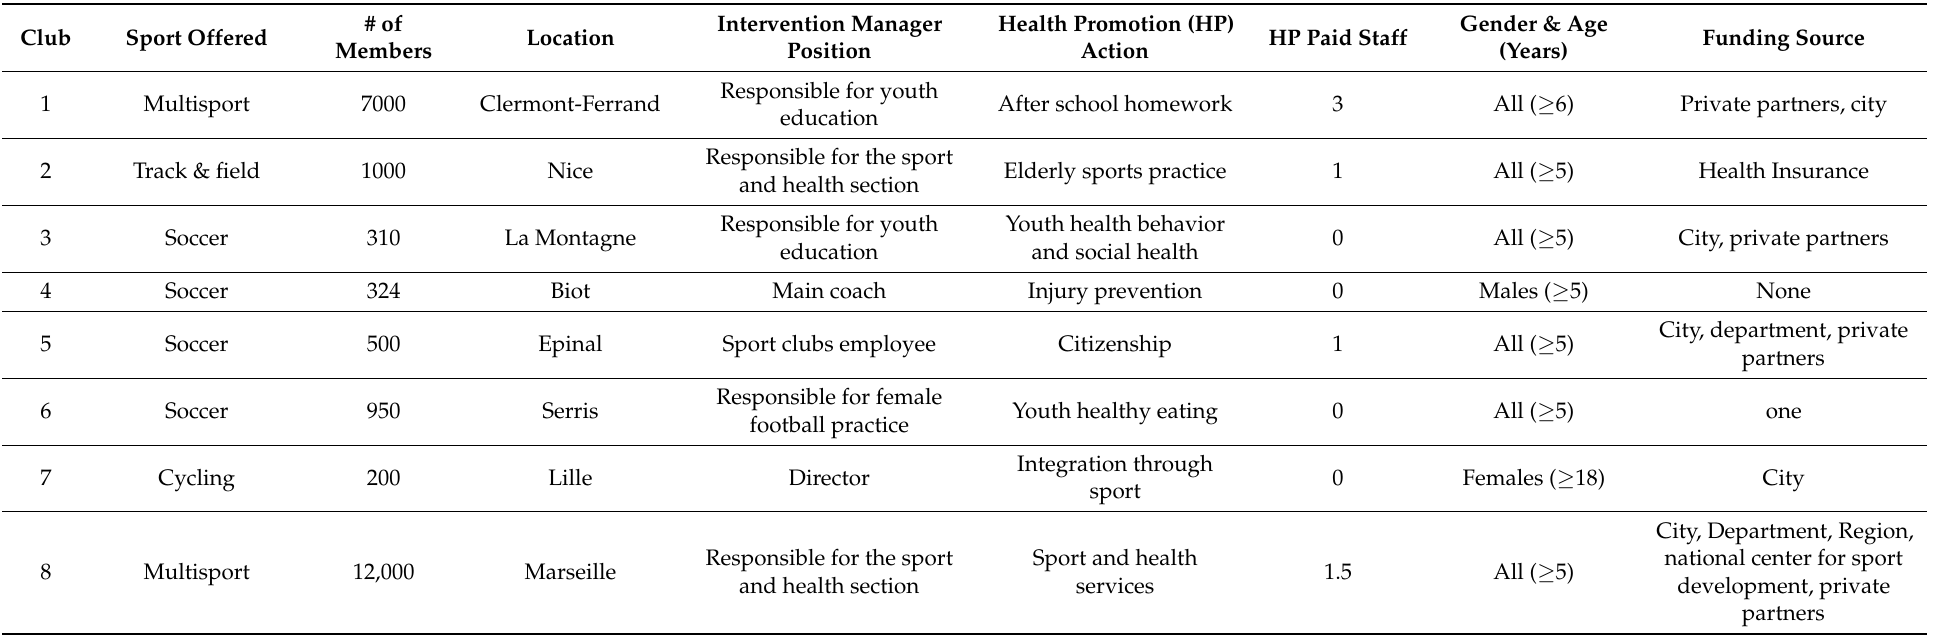
Table 1. Main characteristics of the selected sports